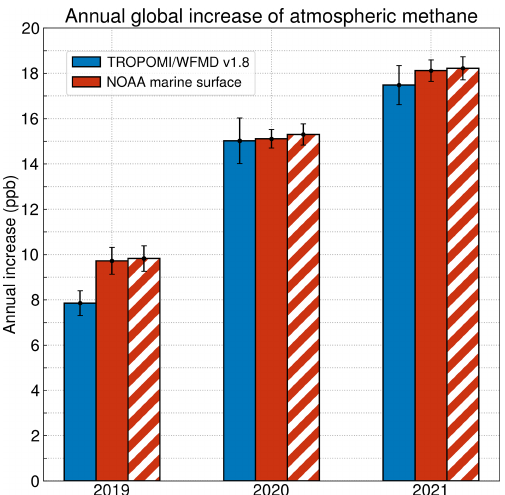
Figure 22. Comparison of the annual globally averaged increases in TROPOMI/WFMD v1.8 XCH 4 (blue) and NOAA marine surface CH 4 (red) as reported by Lan et al. (2022). The hatched red bar is a consistency check illustrating the results when using the method presented here to determine the increases in the globally averaged monthly means provided by NOAA (Lan et al.,